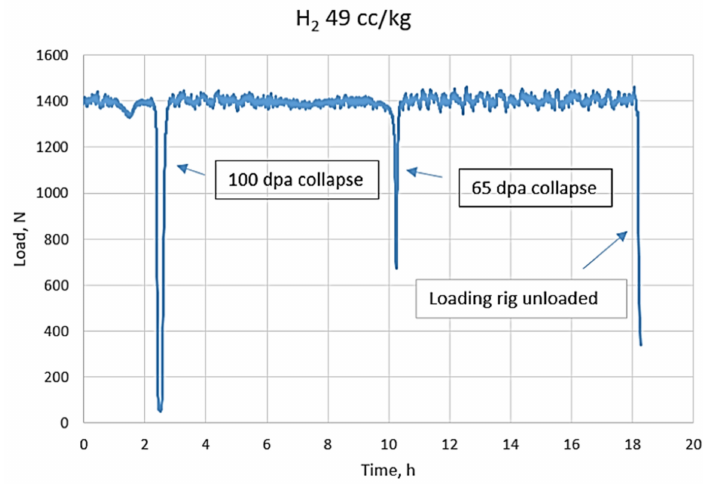
Figure 24. Applied load during the test in PWR water with higher dissolved hydrogen level (49 cc/kg).